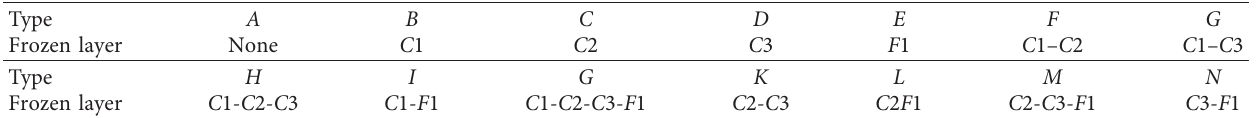
Figure 16: Noised image samples with a SNR of 10dB: (a) EP; (b) IMFA; (c) SPCI; (d) GTM. Table 10: Types of frozen layer